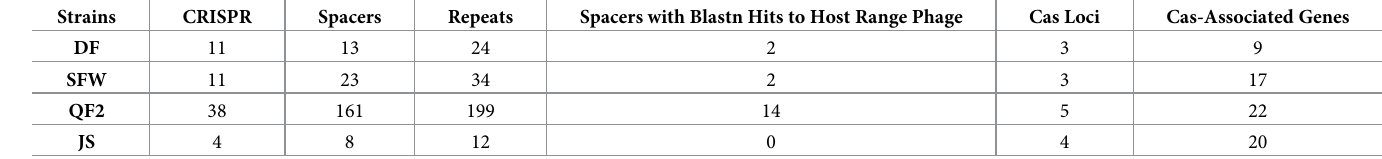
Included in this table is the number of spacers within the genome of each bacterial strain with sequence similarity to regions within any of the four phage isolates (IceWarrior, TrvxScott, BartholomewSD, or